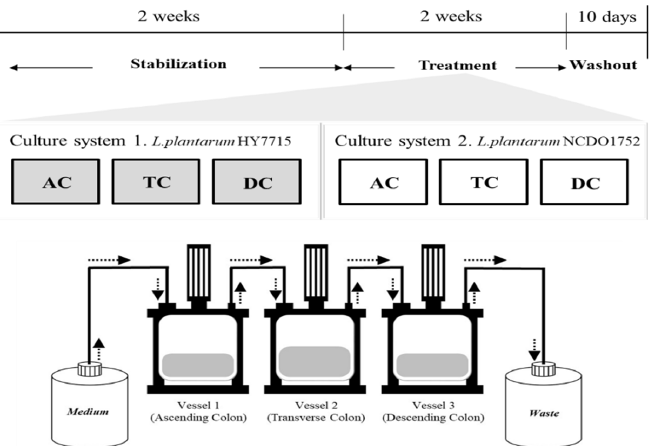
Figure 1. Schematic diagram of the continuous culture system employed in this study: ACascending colon; TC—transverse colon; DC—descending colon. ascending colon; TC—transverse colon; DC—descending